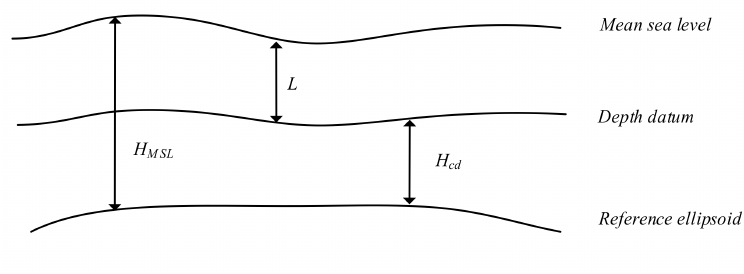
Figure 1. Spatial relations among several vertical datums in the ocean.